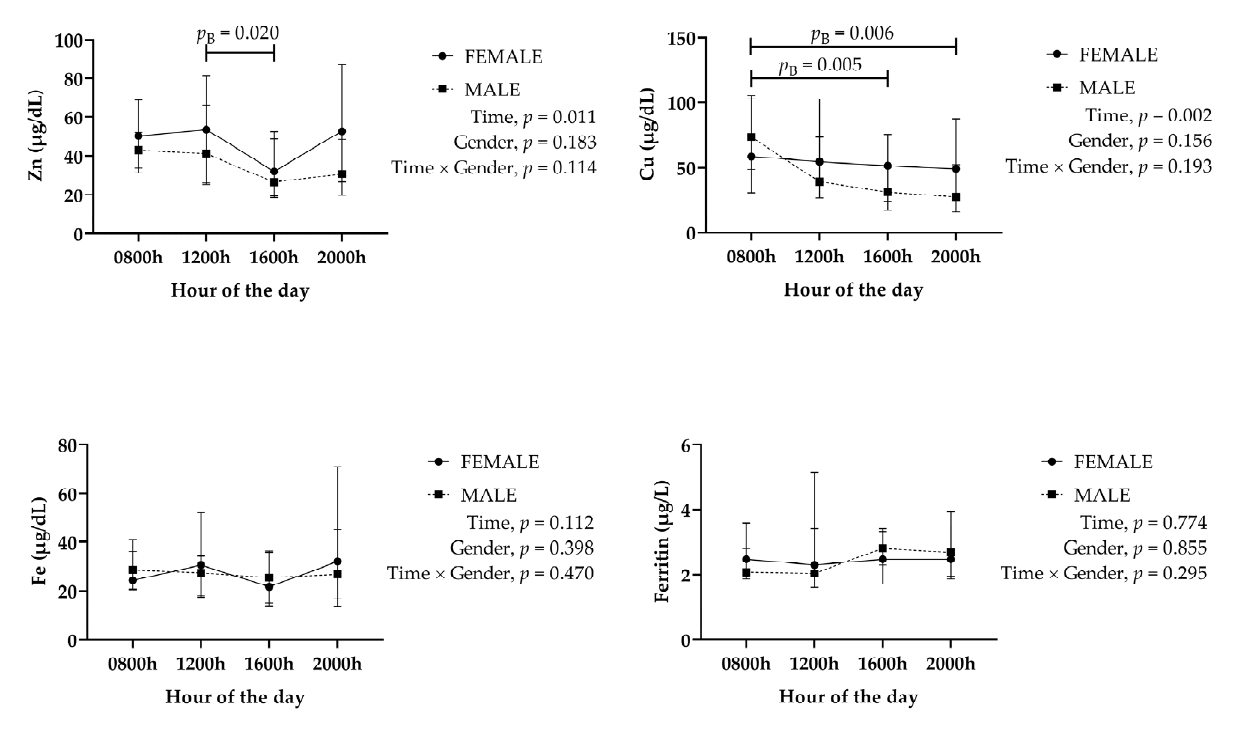
Figure 1. Results for the zinc (Zn), copper (Cu), iron (Fe) and ferritin concentrations obtained in saliva from 40 healthy fattening pigs (20 females, 20 males) at different hours of the day. p B : p value of the Bonferroni post hoc analysis.